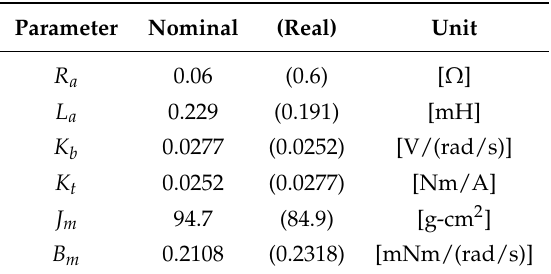
Figure 2. DC motor control system for experimental tests. Table 1. System